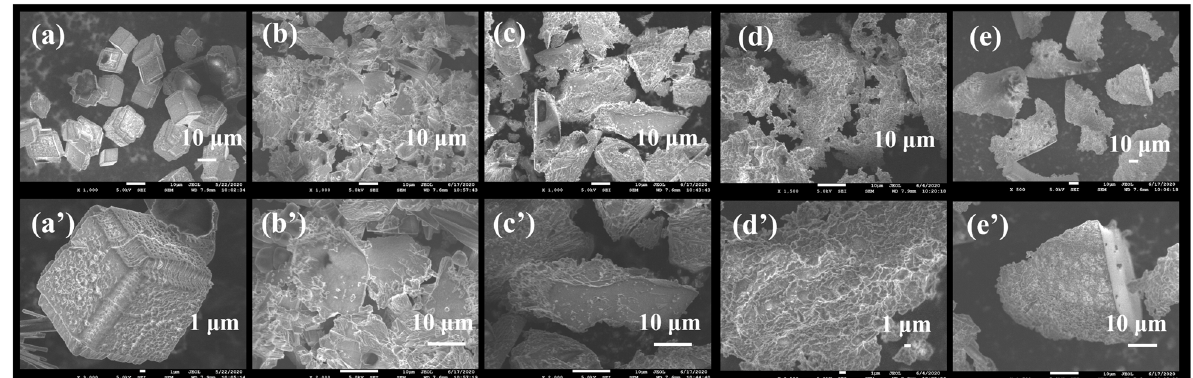
Fig. 6 SEM images of CaCO 3 scale at different magni fi cations. a , a ’ Without antiscalant, b , b ’ with 10 mg/L PASP, c , c ’ with 30 mg/L PASP, d , d ’ with 10 mg/L